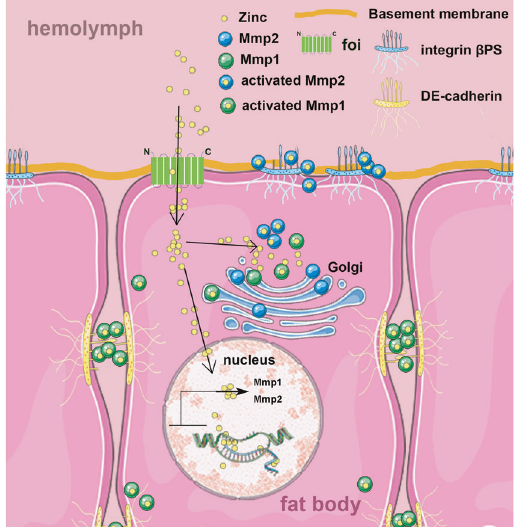
Fig. 7 A model to explain the effect of foi on cell dissociation. In the fat body of Drosophila melanogaster , foi transports zinc into cytosol. In addition to direct activating Mmp activity, the increased zinc level in the cytosol also results in increased zinc in the nucleus which could induce the transcription of Mmp1 and Mmp2 . Mmps are involved in the progression of cell dissociation by promoting the degradation and hydrolysis of extracellular matrix